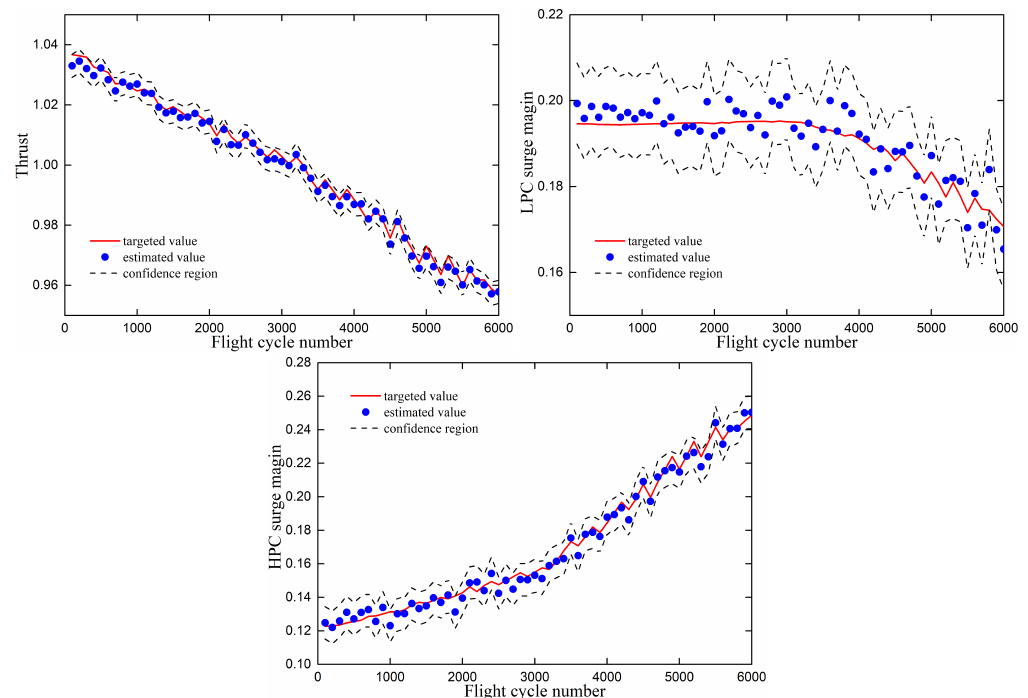
Figure 6. Prediction results for thrust and surge